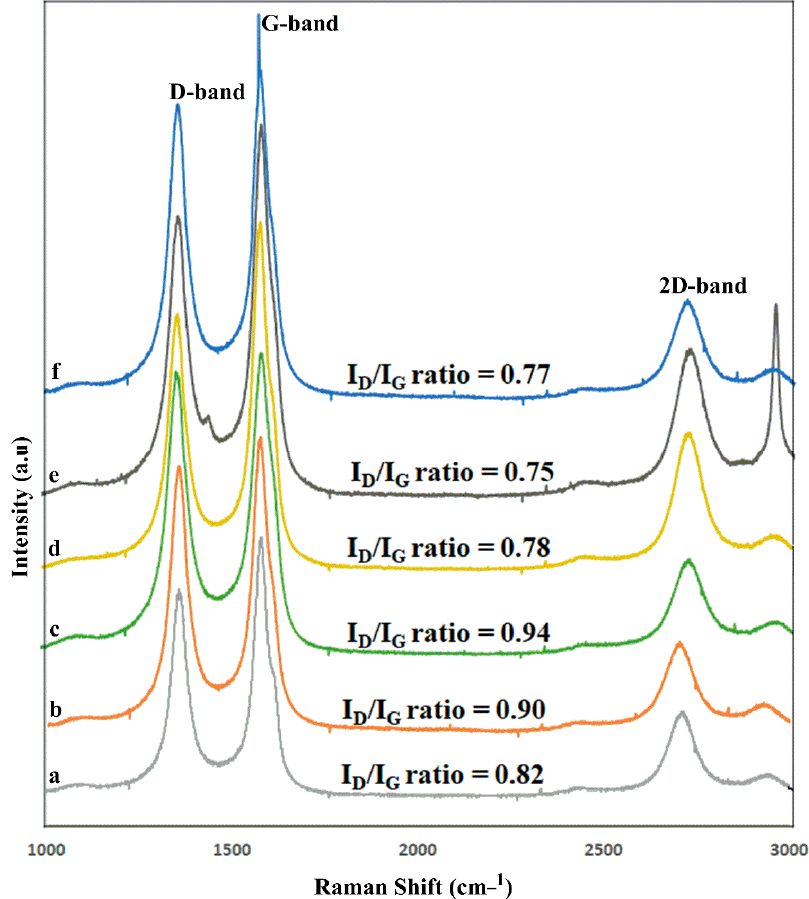
Figure Figure 5. Raman spectra of the modified MWCNTs formulations: ( a ) COOHMWCNTs, ( b ) COClMWCNTs, ( c ) LyMWCNTs, ( d ) GAMWCNTs, ( e ) MAMWCNTs and ( f ) LAMWCNTs. Table 2. Raman spectra of the D-band, G-band and 2D-band wave number (cm − 1 ) and the I D /I G ratio of the formulations.